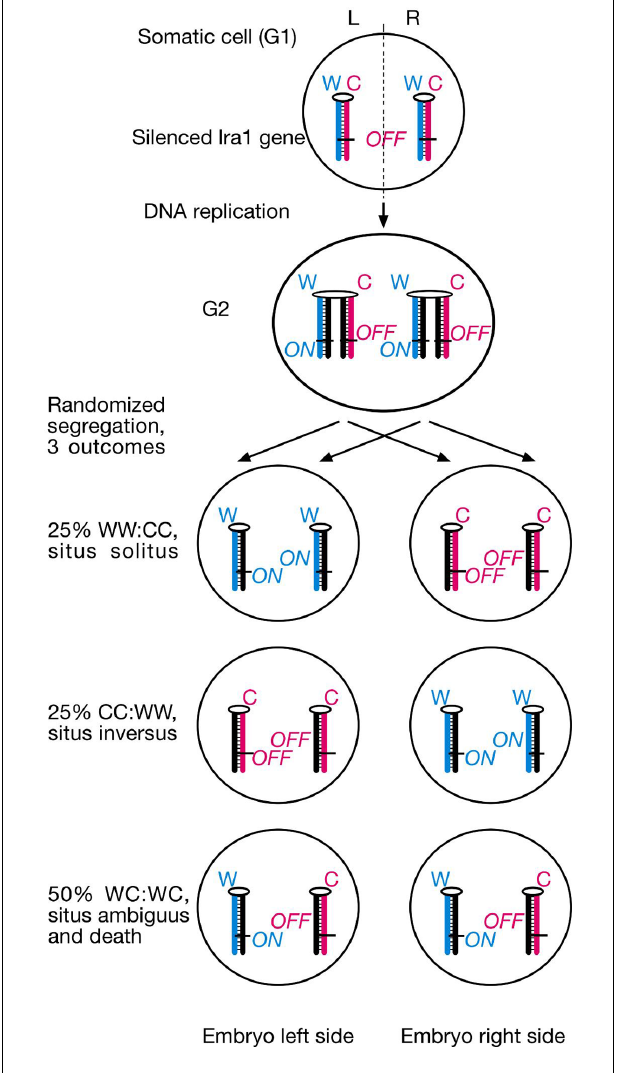
FIGURE 2 | SSIS-predictions concerning embryo situs and survival rates of lrd mutants. Proposed laterality-generating asymmetric cell division is randomized in the lrd mutant.The future L/R axis is set by cytoplasmic polarization and alignment of a single cell with respect to the anterior-posterior and dorsal-ventral body axes. Sister chromatids containing a hypothetical “leftness-encoding” left-right axis-establishing gene 1 ( lra1 ) are epigenetically differentiated. Normally, left-right dynein would selectively segregate olderWatson template strand-containing sister chromatids harboring lra1 “ ON ” epialleles to the left body side, and older Crick template strand-containing sister chromatids harboring lra1 “ OFF ” epialleles to the right body side as described in Figure 1A. Randomized segregation due to left-right dynein mutation will result in three different outcomes shown here: 25%WW:CC cell pairs, causing normal situs development, 25% CC:WW cell pairs, causing development of situs inversus, and 50%WC:WC cell pairs, causing severe developmental situs abnormalities incompatible with survival.